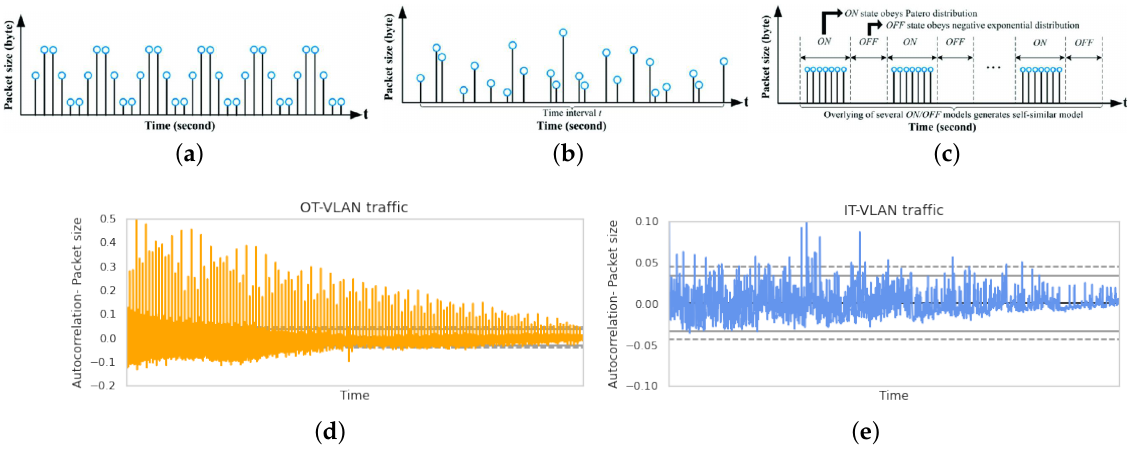
Figure 6. Data packet generation models in literature: ( a ) cyclic, ( b ) stochastic and ( c ) burst [20] vs. brown-field: ( d ) OT- VLAN (cyclic) and ( e ) IT-VLAN